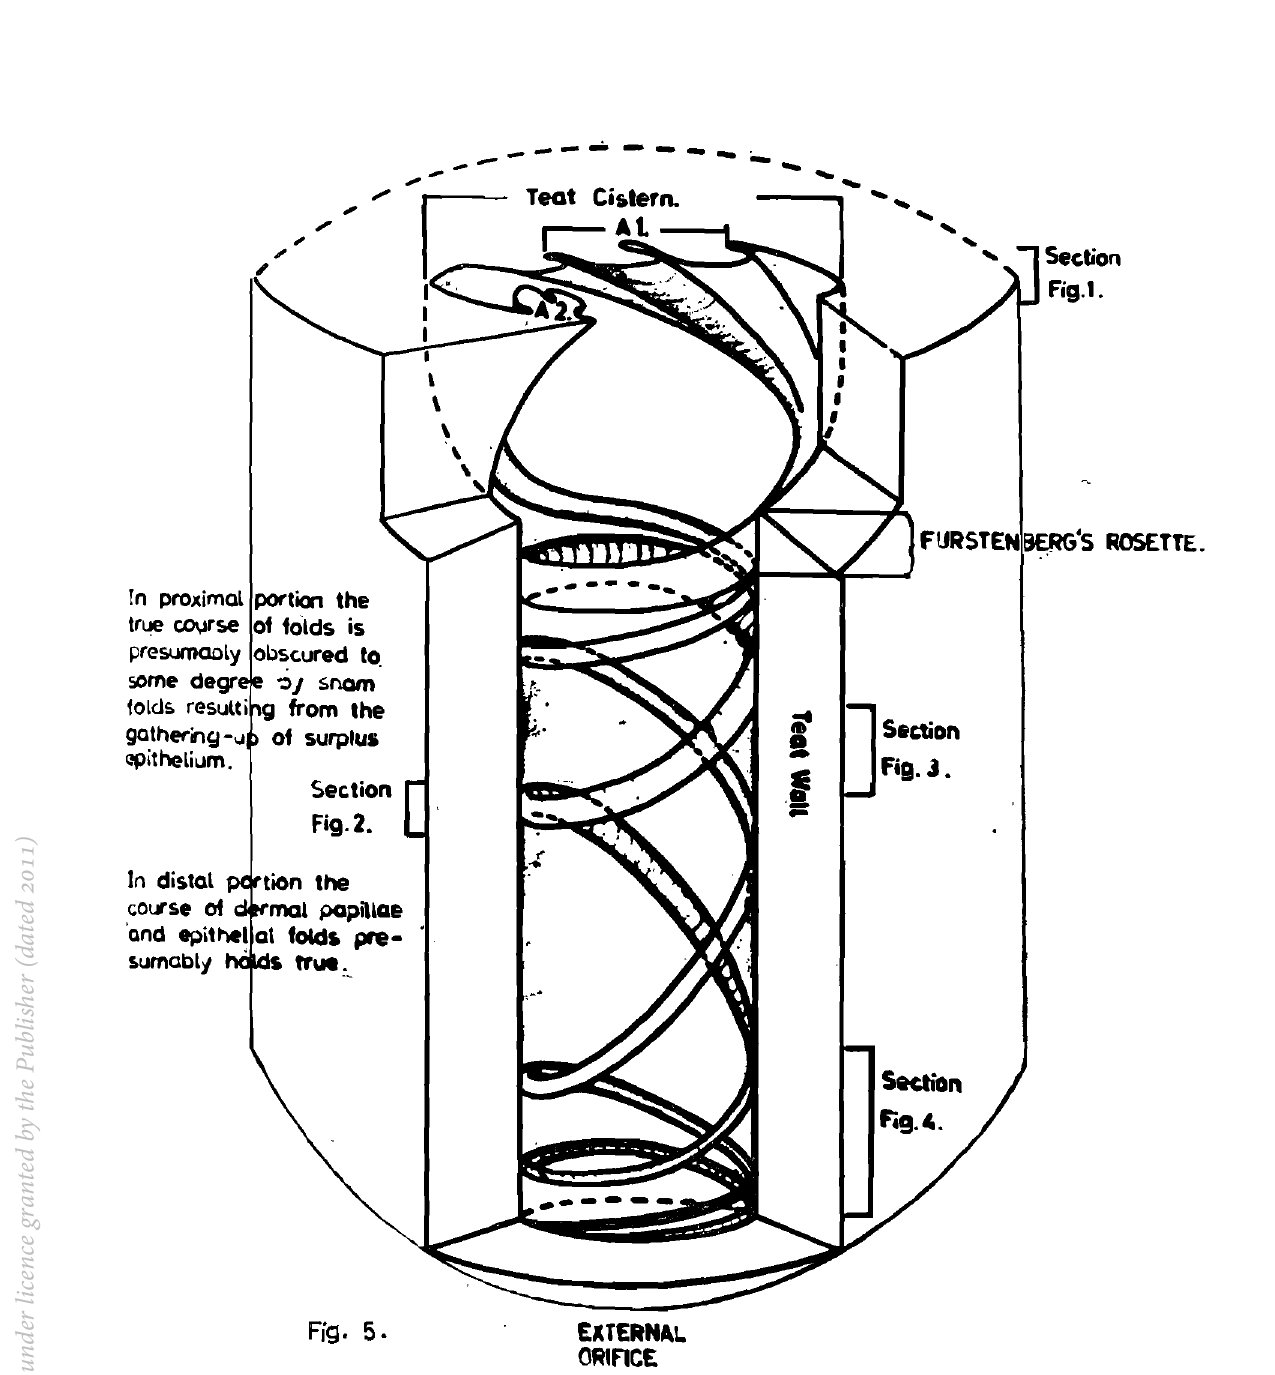
Fig. 5. ElTERN~1. ORIFICE Fig. I: A cross-section of the teat cistern just proximal to Furstenberg's rosette. The direction of the epithelial folds at A suggests spiralling in at least one direction, whereas the folds at B possibly suggest couter.spiralling. HE, 30 x . Fig. 2: A cross-section of the proximal portion of a dilated teat canal. The direction of epithelial folds and dermal papillae (arrows) suggests spiralling in at least one directibn; counter-spiralling is possible. HE, 30 X • Fig. 3: A longitudinal section of the proximal portion of a dilated teat canal. The direction of dermal papillae (arrows) _ including the partially cut ones - suggests spiralling of the teat canal epithelium. HE, 70 x. Fig. 4: A longitudinal section of the external surface of a dilated teat canal. The direction of proximal dermal papillae at A suggests a steep course of epithelial folds coming from the proximal portions of the teat canal, whereas that of the dermal papillae at B suggests a horizontal course. Gomori's silver technique. 70 X • Fig. 5: A proposed scheme of epithelial spirals in a teat canal reco:utructed from a series of micrographs. Only two epithelial spirals have been shown.